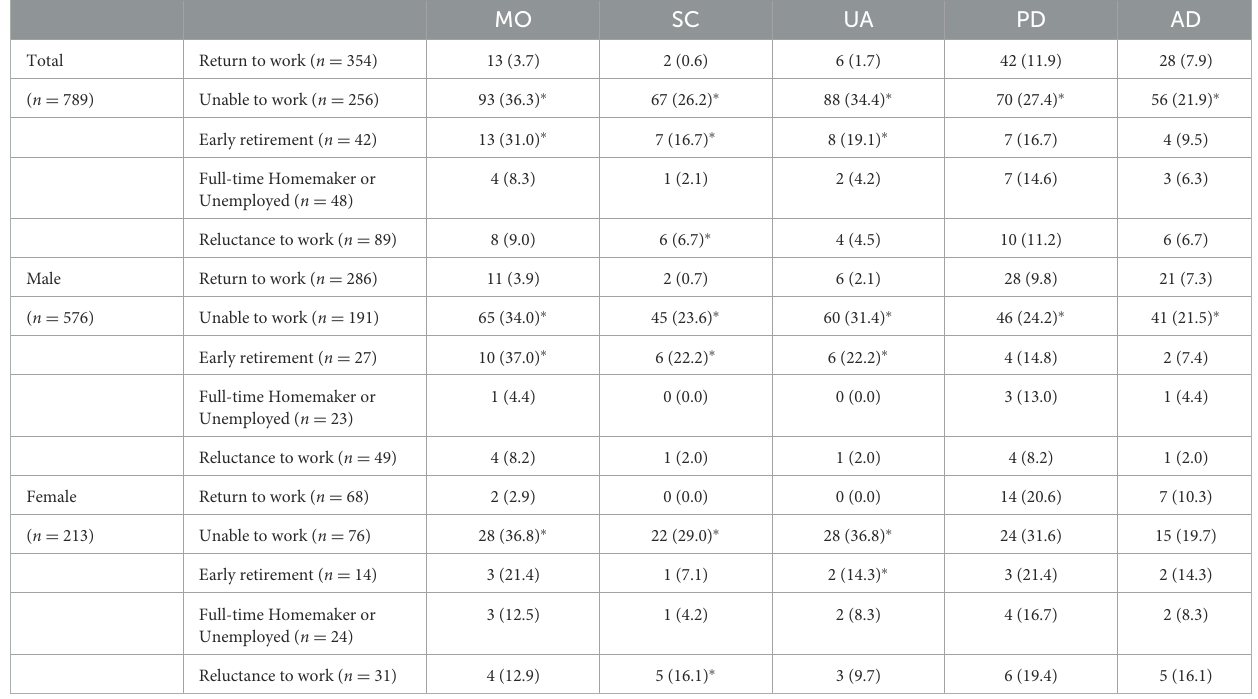
TABLE 4 Percentage of health problems in five dimensions of EQ-5D-5L, stratified by gender [ n